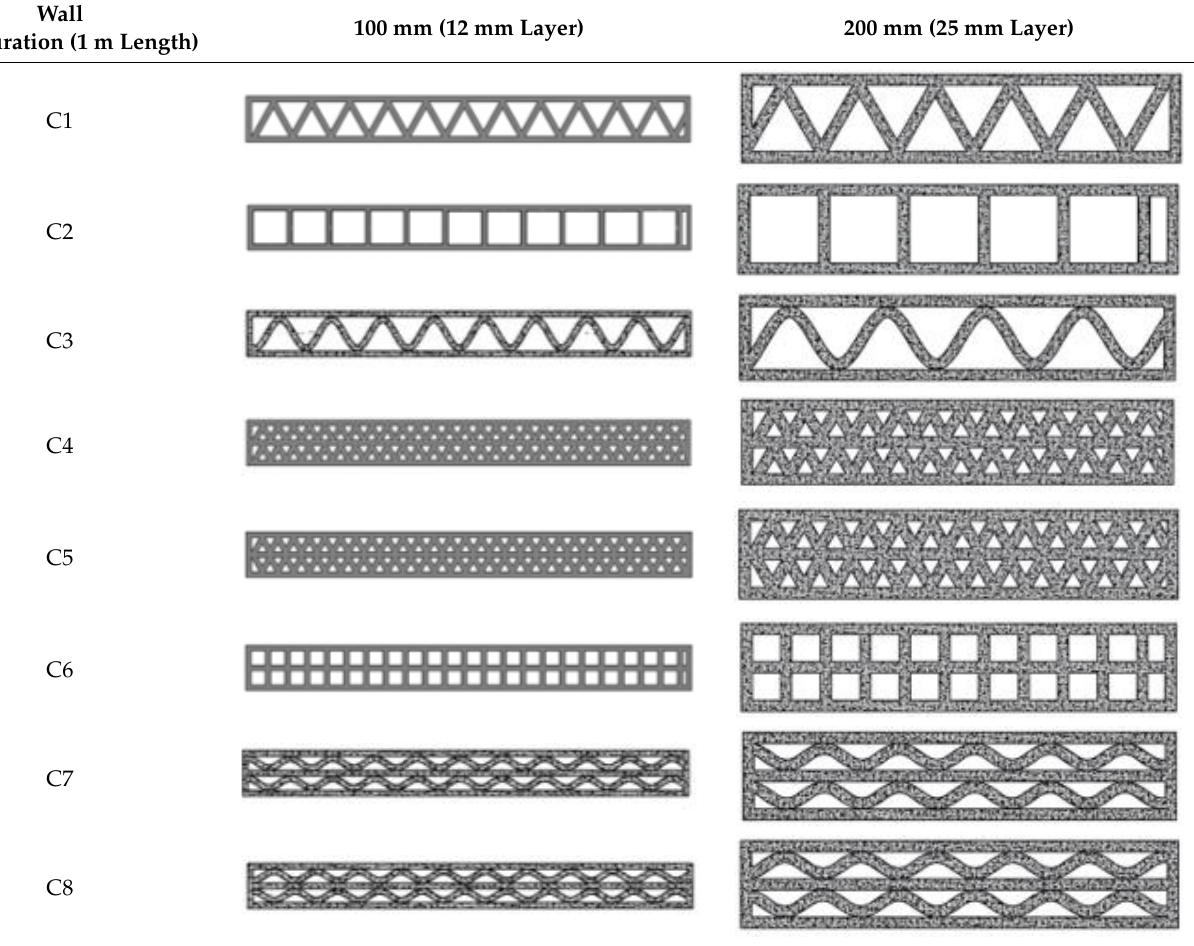
Table 4. Different cross-sectioned 3DPC wall configurations.